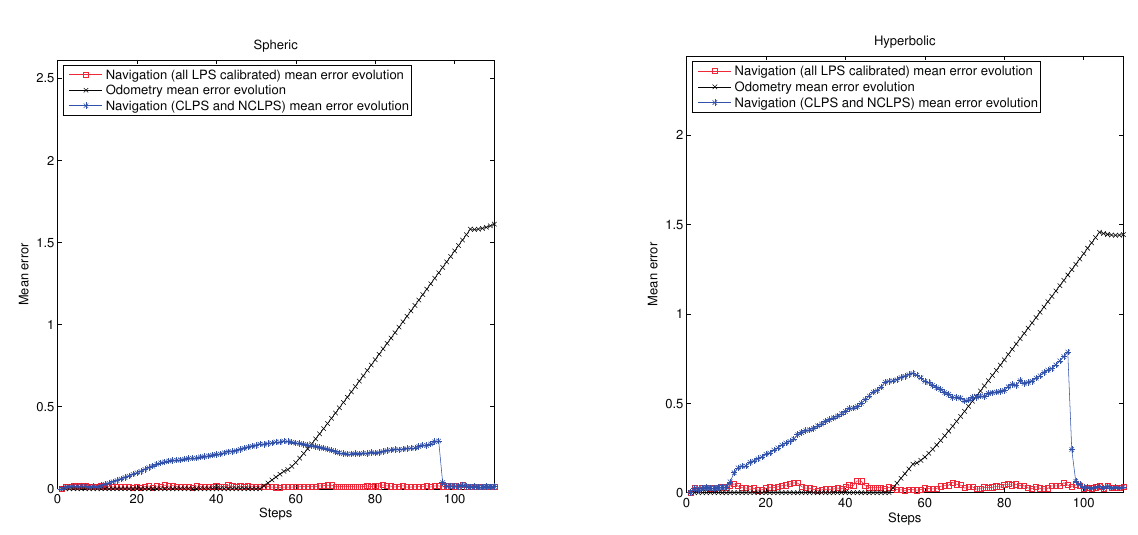
Figure 5. Accumulative mean error evolution. ( Left ) Spherical case; ( right ) hyperbolic case.